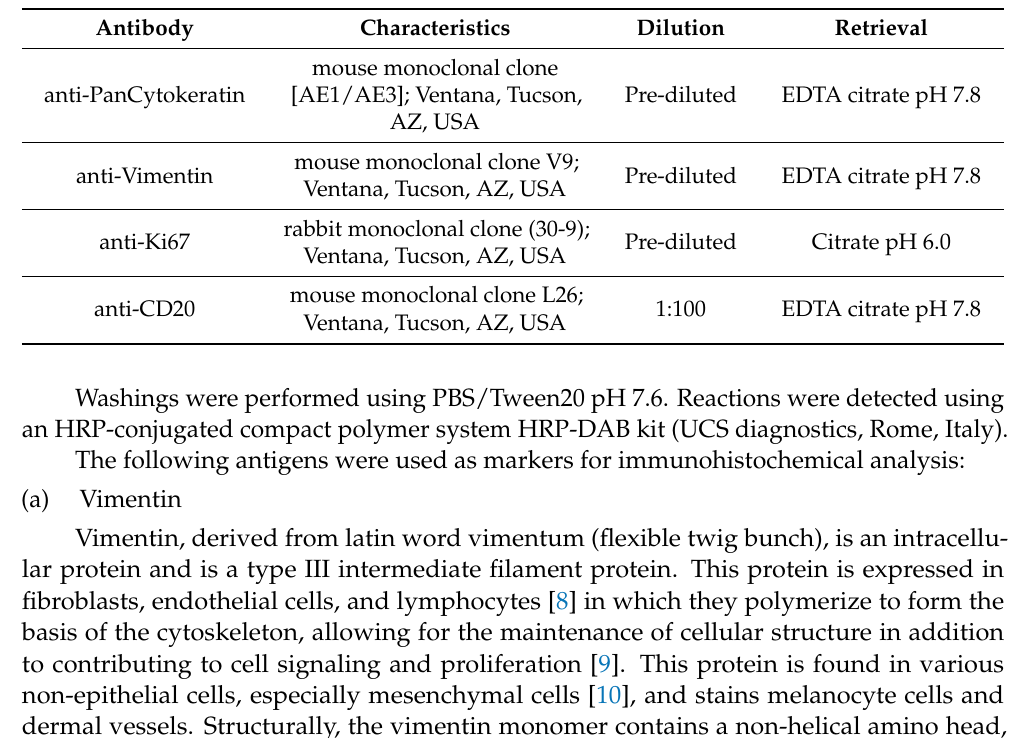
Table 1. List of primary